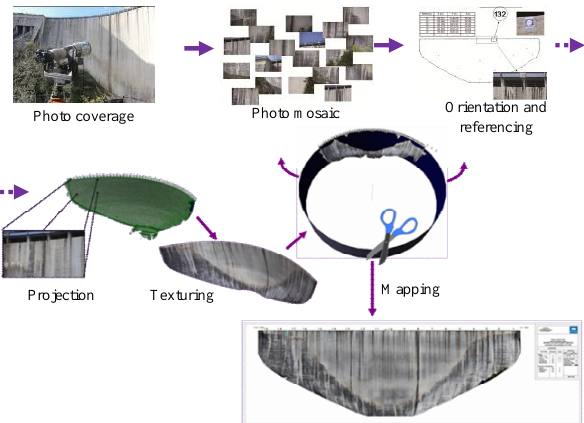
Figure 7. Block diagram of orthophotography operations